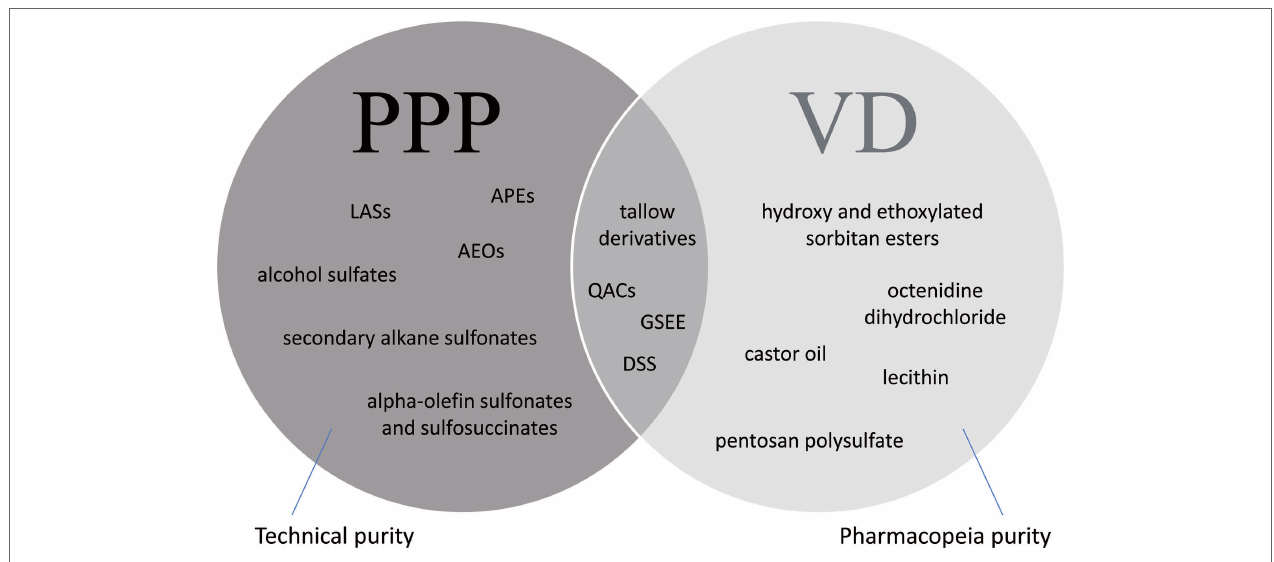
FiGURe 5 | Surfactants used in veterinary drugs (VDs) and plant protection products (PPPs) indicating exemplary substances used particularly in VDs, in PPPs (APEs, alkylphenol ethoxylates; LASs, linear alkylbenzene sulfonates; AEOs, alcohol ethoxylates), or in both groups (tallow derivatives: hydrogenated and polyethoxylated tallow substances, QACs, quaternary ammonium compounds; GSEEs, glycerol sorbitane ester ethoxylates; DSS, dioctyl sodium sulfosuccinate). Additives in VDs are required to be of Pharmacopeia purity, while formulants in PPPs can be used in technical